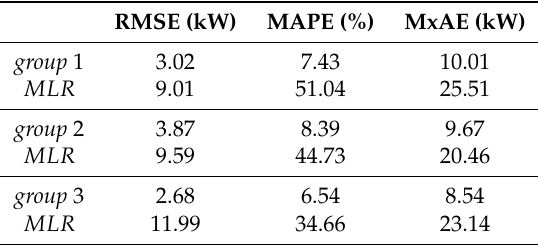
Table 5. Comparison of forecasting results in MLR.